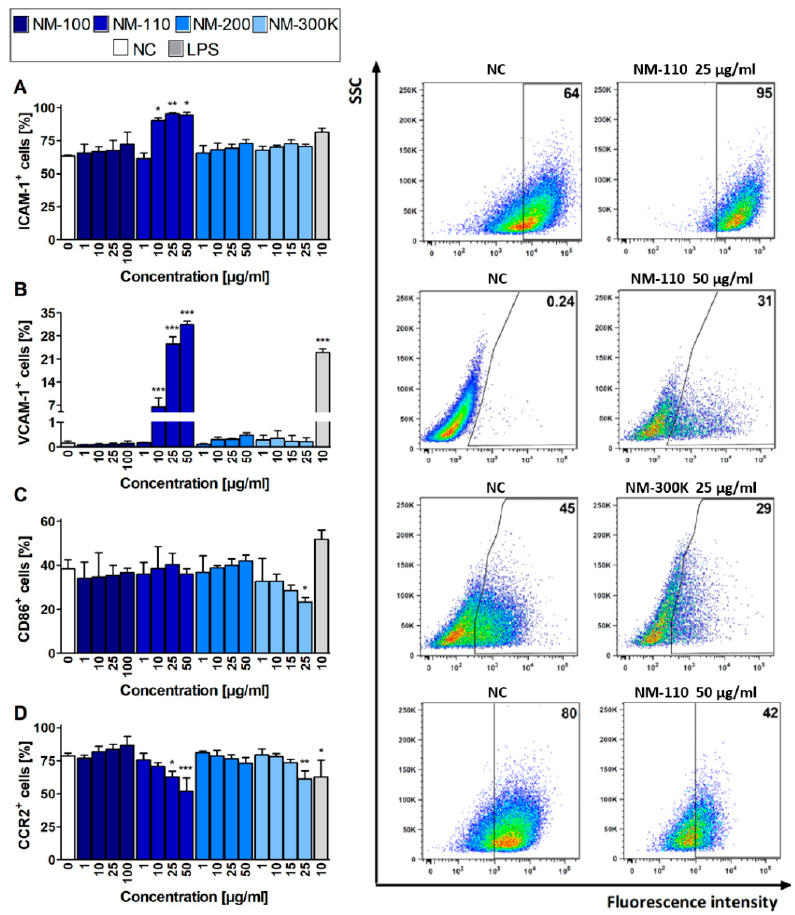
Figure 4. Flow cytometry analyses of expression of selected markers. Bar plots (expressed as mean ± SD) indicate percentages of ICAM-1 ( A ), VCAM-1 ( B ), CD86 ( C ), and CCR2 ( D ) positive cells after 24-h exposure. Representative dot plots for each marker demonstrate differences for selected exposures to NPs compared to untreated cells (NC). Data presented in dot plots are from one experiment and represent selected results of three independent experiments. ANOVA, followed by Dunnett’s Multiple Comparison, was used for statistical analysis of the results. * p < 0.05, ** p < 0.01, *** p < 0.001. SSC—side-scattered light.